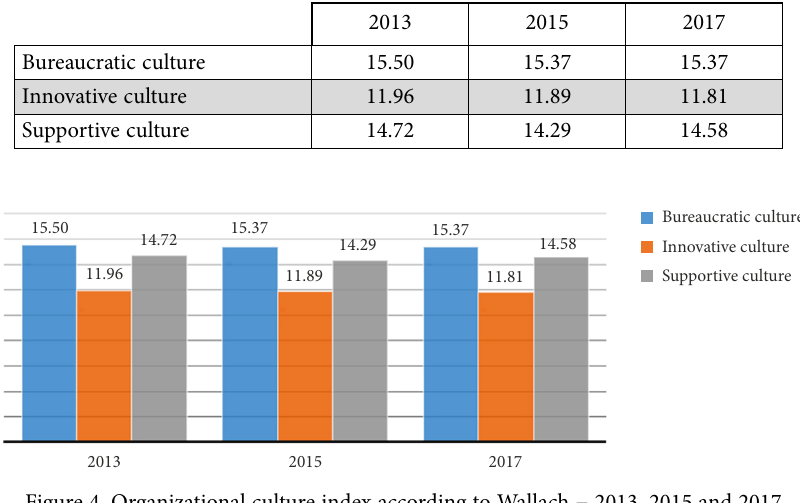
Figure 4. Organizational culture index according to Wallach − 2013, 2015 and 2017 (source: Prepared by the authors)